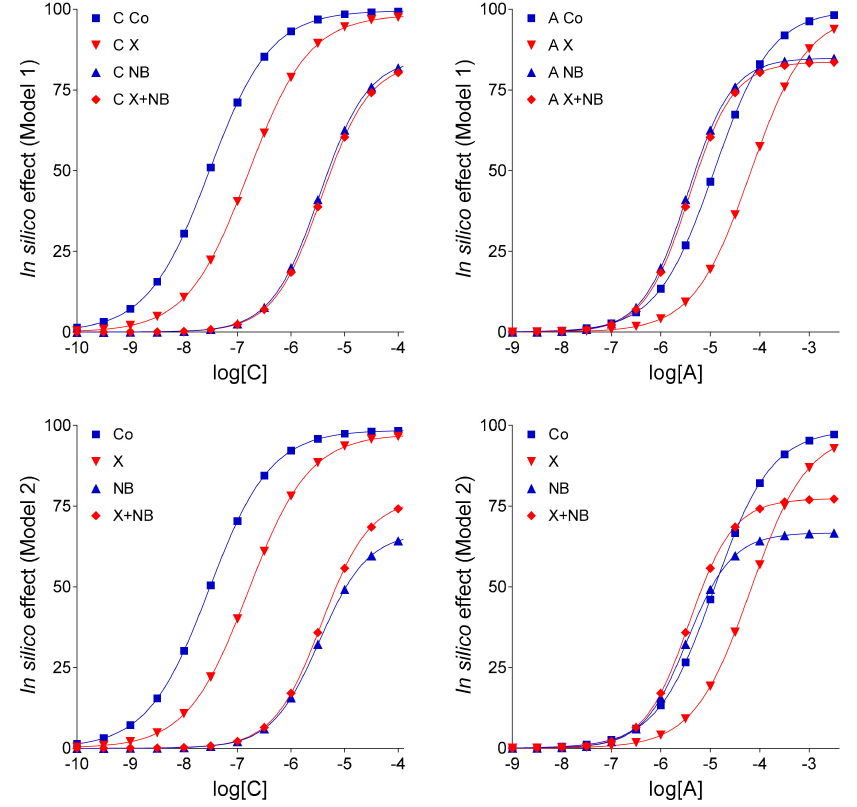
Figure 2. Simulated concentration-response (E / c) curves of agonist C (representing CPA, a synthetic A 1 adenosine receptor agonist with long half-life) and agonist A (symbolizing adenosine, the physiological adenosine receptor agonist with short half-life), according to Models 1 and 2 (modelling the supraventricular myocardium, where A 1 adenosine receptor agonists exert strong direct negative inotropic e ff ect). The only di ff erence between Model 1 and Model 2 is the value of the E m parameter (100 and 99, respectively, see Equations (1) and (2)). The E / c curves show the influence of agent NB (representing NBTI, a nucleoside transport inhibitor) on the e ff ect evoked by agonist C and A, without (blue curves) and with (red curves) a pretreatment with agent X (representative of FSCPX, a chemical known as an irreversible A 1 adenosine receptor antagonist). The x -axis denotes the common logarithm of the molar concentration of the given agonist (in the organ bath), and the y -axis shows the e ff ect. The lines represent the fitted Hill equation (see Equation (4)). CPA: N 6 -cyclopentyladenosine; FSCPX: 8-cyclopentyl- N 3 -[3-(4-(fluorosulfonyl)benzoyloxy)propyl]- N 1 -propylxanthine; NBTI: S -(2-hydroxy-